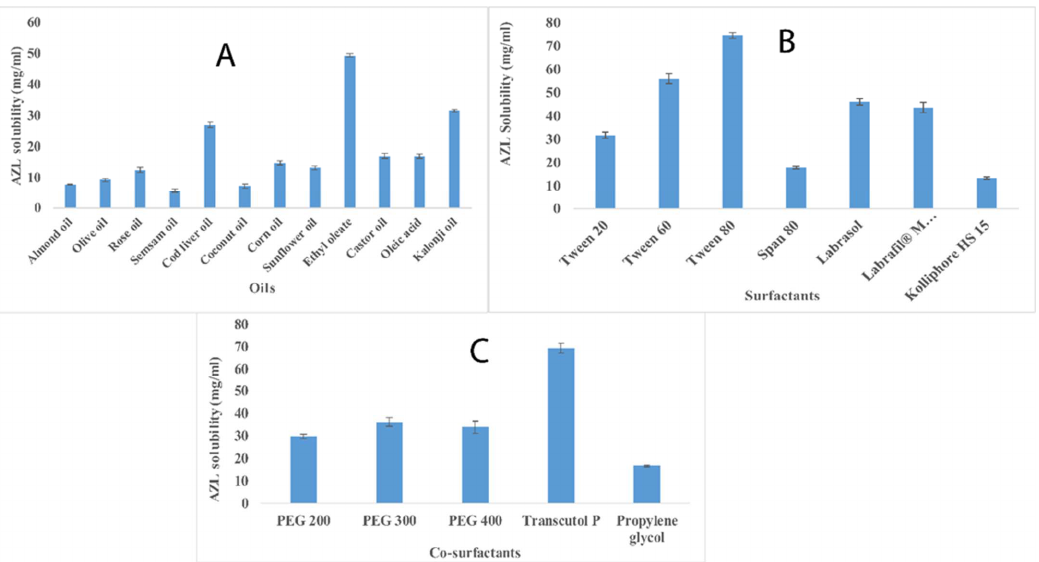
Figure 1. ( A – C ) depict the solubility of azilsartan medoxomil in various oils, surfactants, and co-surfactants. (43.67 mg/mL), and tween 20 (32.76 mg/mL) (Figure 1B). The highest solubility of AZL in